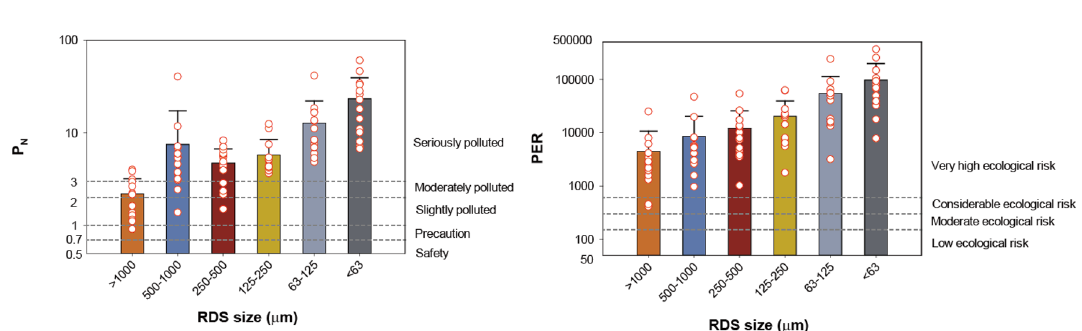
Figure 3. Comparison of nemerow index (P N ) and potential ecological risk index (PER) of the difference sizes of road deposited sediments of this study.